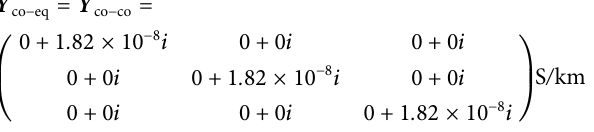
Equivalent parameters of GIL actual parameters Absolute deviation Relative core wire